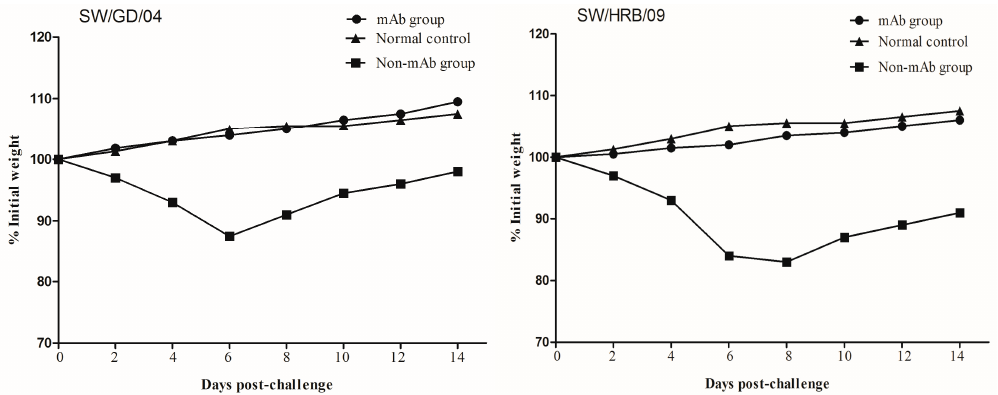
Figure 5. Weight changes in mice after challenge with SW/GD/04 and A/Swine/Harbin/2009 (SW/HRB/09) viruses. Groups of treated and untreated mice were intranasally inoculated with 10 6 EID50 of SW/GD/04 and SW/HRB/09 24 h after the mAb 8C6 treatment. The body weights of each mouse were monitored at two-day intervals for two weeks. Values indicate the mean weight changes of all of the mice in each group after virus challenge. Table 2. Protection of mice by the mAb 8C6.